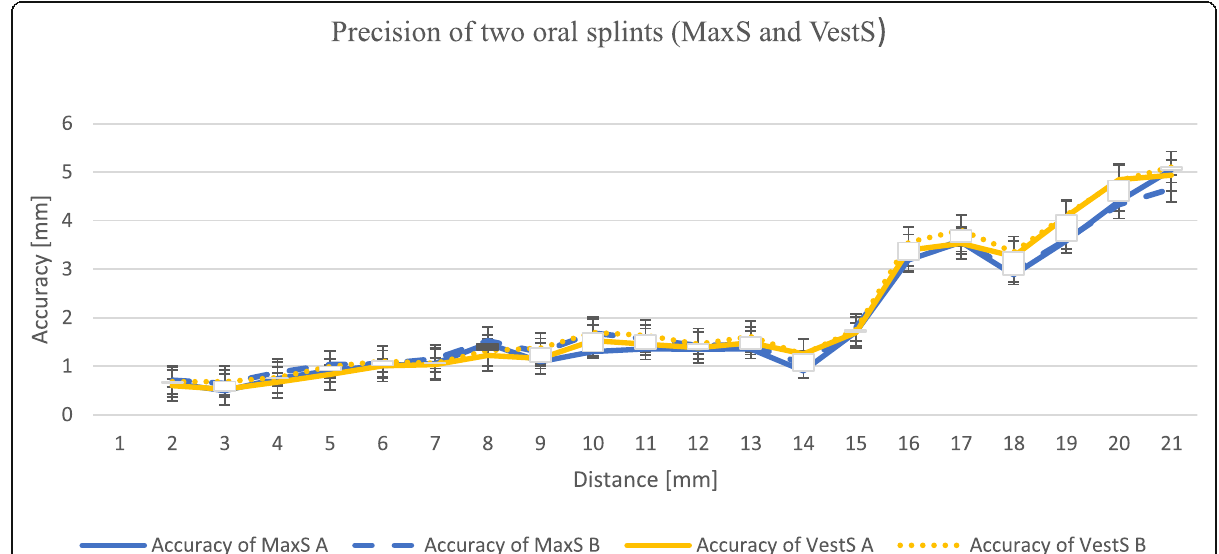
Fig. 6 Accuracy of two oral splints for guided surgery immediately after fabrication and after ten attempts in relation to distance (mm). Data are given as mean ± standard deviation. MaxS A chairside fabricated maxillary splint, fixed on the dentate maxilla (Group A) immediately after fabrication. MaxS B chairside fabricated maxillary splint, fixed on the dentate maxilla (Group B) after ten attempts (removing and reattaching). VestS A chairside fabricated vestibular splint (pacifier), fixed as intermaxillary pacifier immediately after fabrication. VestS B chairside fabricated vestibular splint (pacifier), fixed as intermaxillary pacifier after ten attempts (removing and